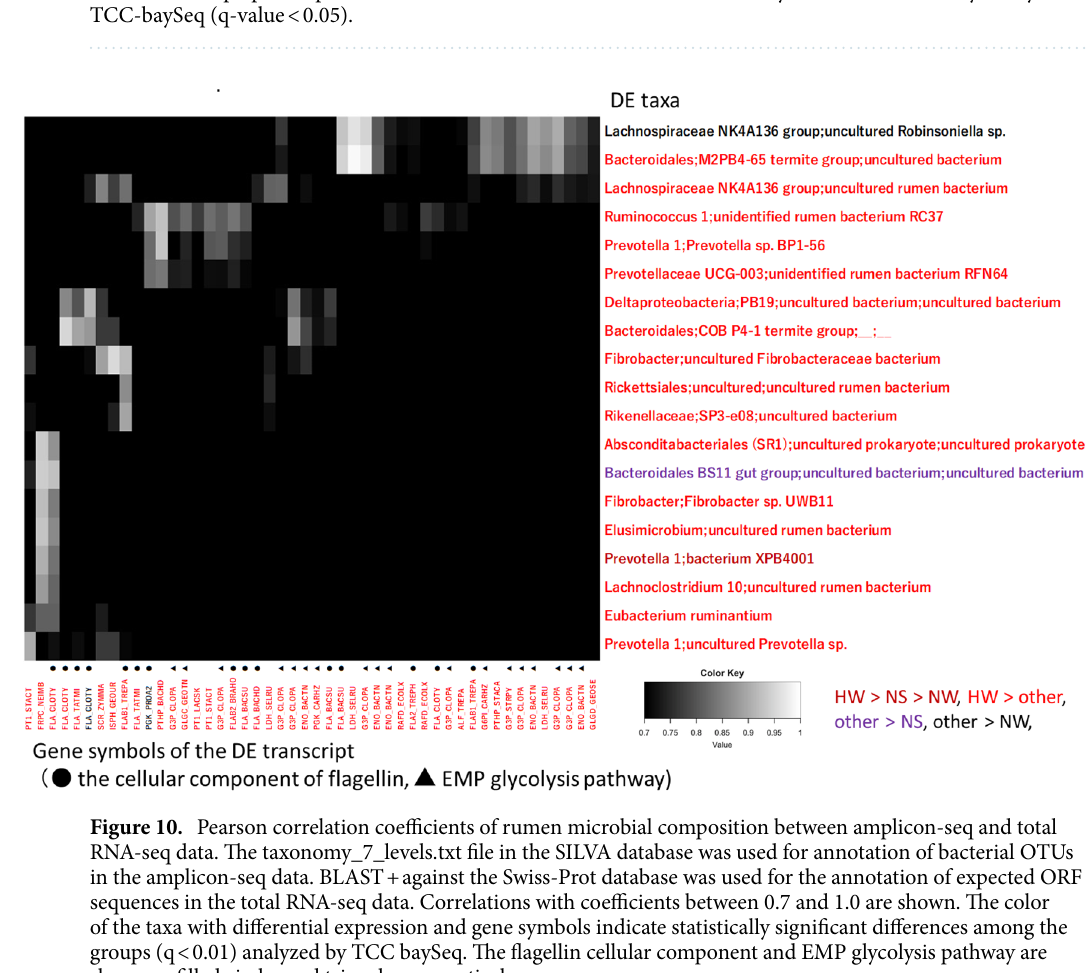
Table 3. Group-specific predicted taxa in the ruminal microbes annotated by Swiss-Prot and analyzed by TCC-baySeq (q-value < 0.05).